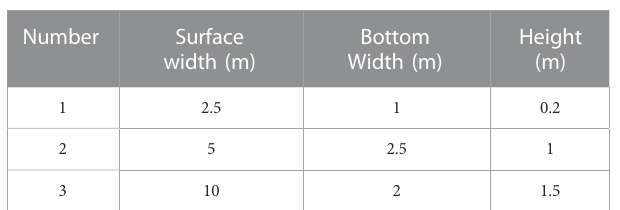
TABLE 2 Strahler dimention